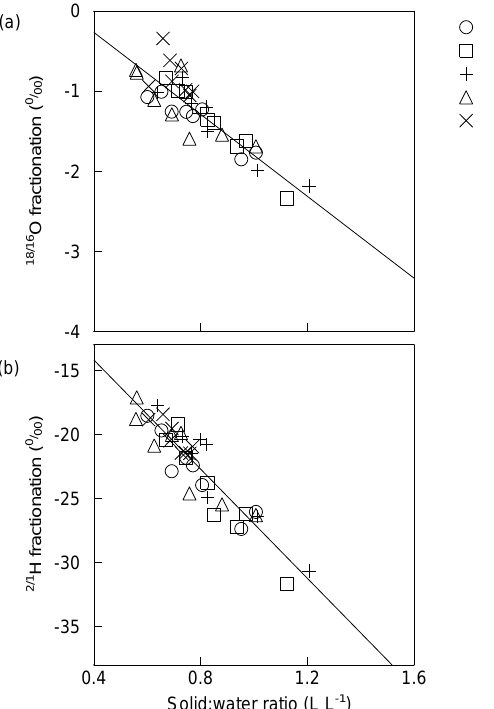
Figure 3. Relationship between volumetric solid:water ratio and apparent (a) 18 / 16 O and (b) 2 / 1 H isotopic fractionation of total wa- ter absorbed by silage compared to unconfined waters with different isotopic composition. The lines show the best fit (see Eq. 7).